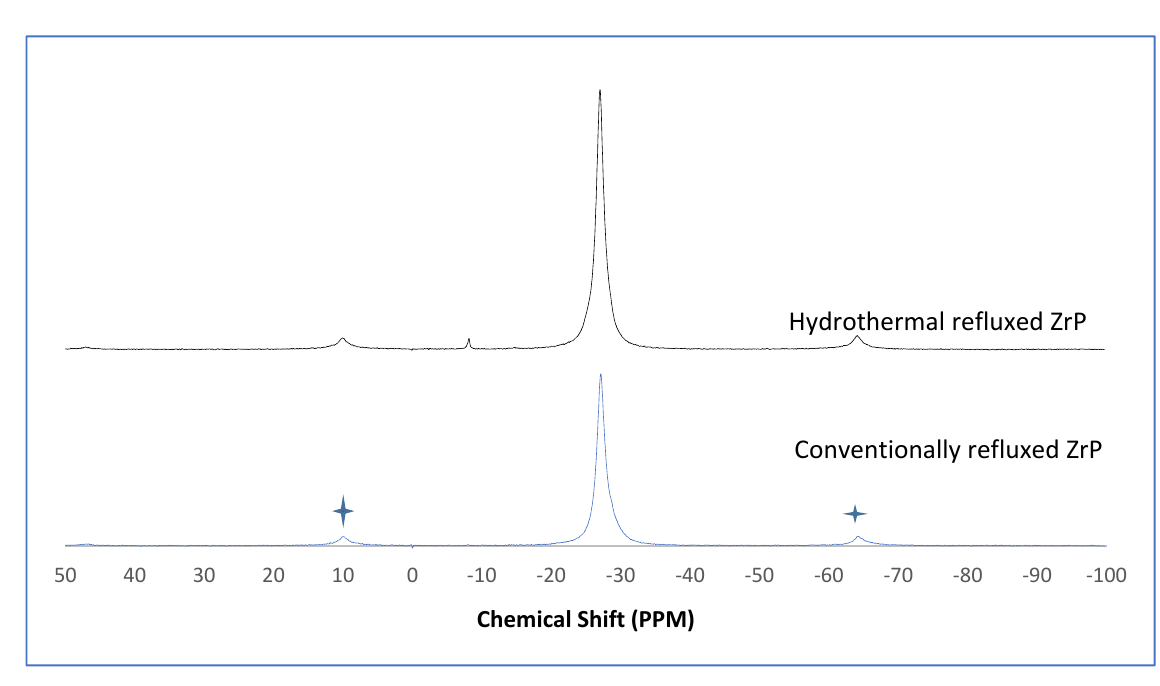
Figure 6. 31 P NMR of α -ZrP synthesised using the two described methods (spinning side bands are shown as ). ChemEngineering 2021 , 5 , x FOR PEER REVIEW